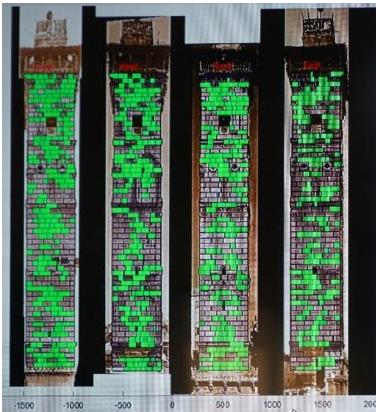
Figure 16. The blocks already identified (October 2018) in green (40% of the